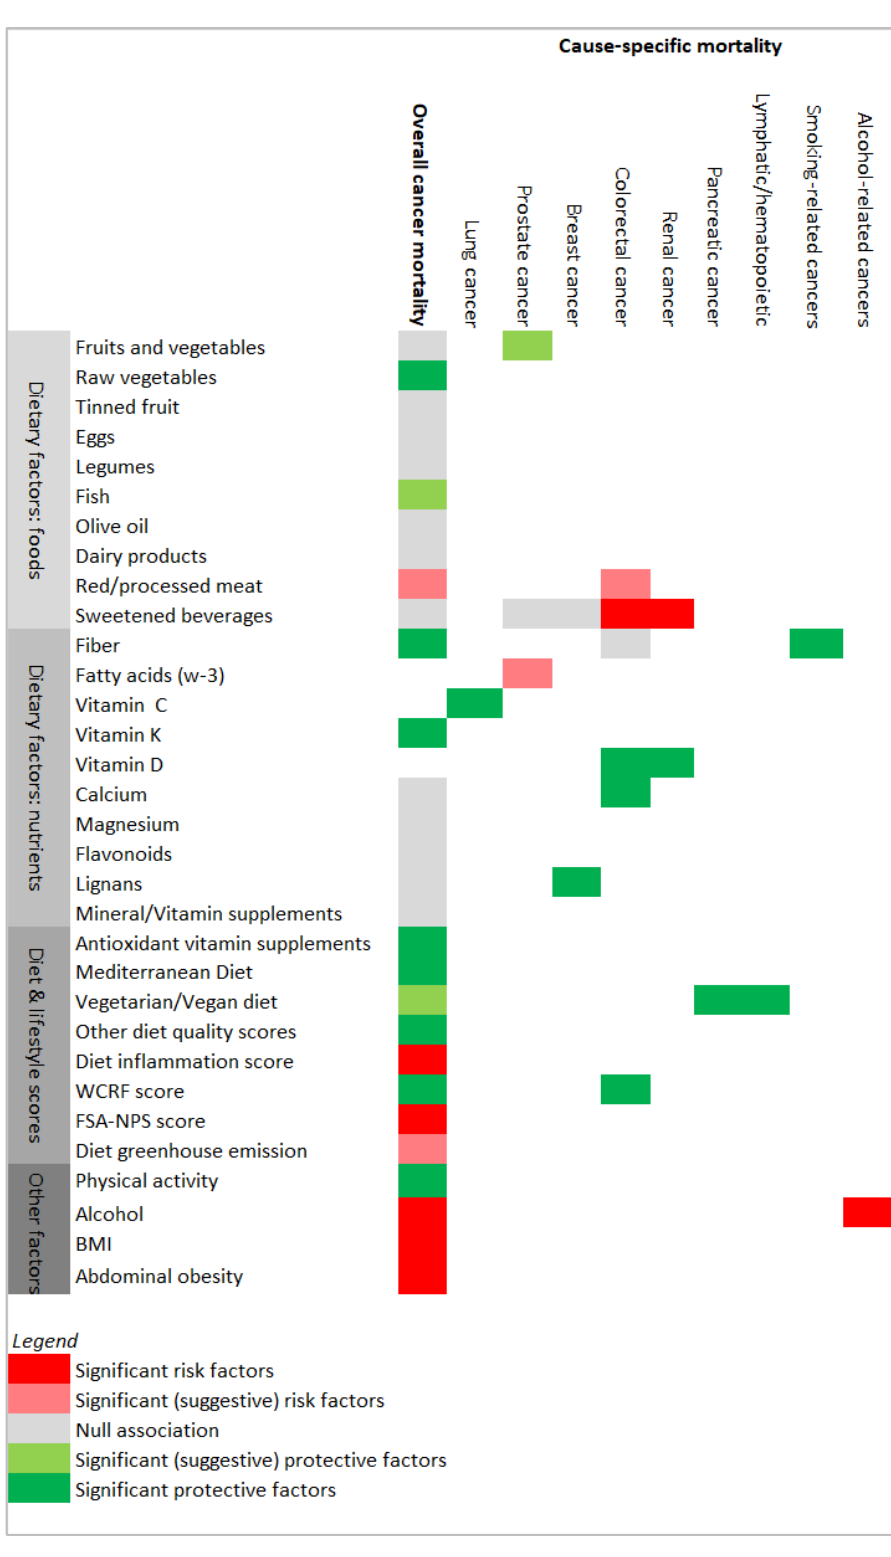
Figure 2. Results’ matrix showing associations between the exposure factors and cancer mortality, overall and by type of cancer. Potential risk factors or protective factors are colored via red or green color scales, respectively. FSA-NPS score (Food Standards Agency nutrient profiling system dietary index score); WCRF score (World Cancer Research Fund score). “Other diet quality scores” included the Diet Quality Index–International, the Healthy Nordic Food Index, the Healthy Eating Index 2010, and the Dietary Approaches to Stop Hypertension score, as described in the Results section.